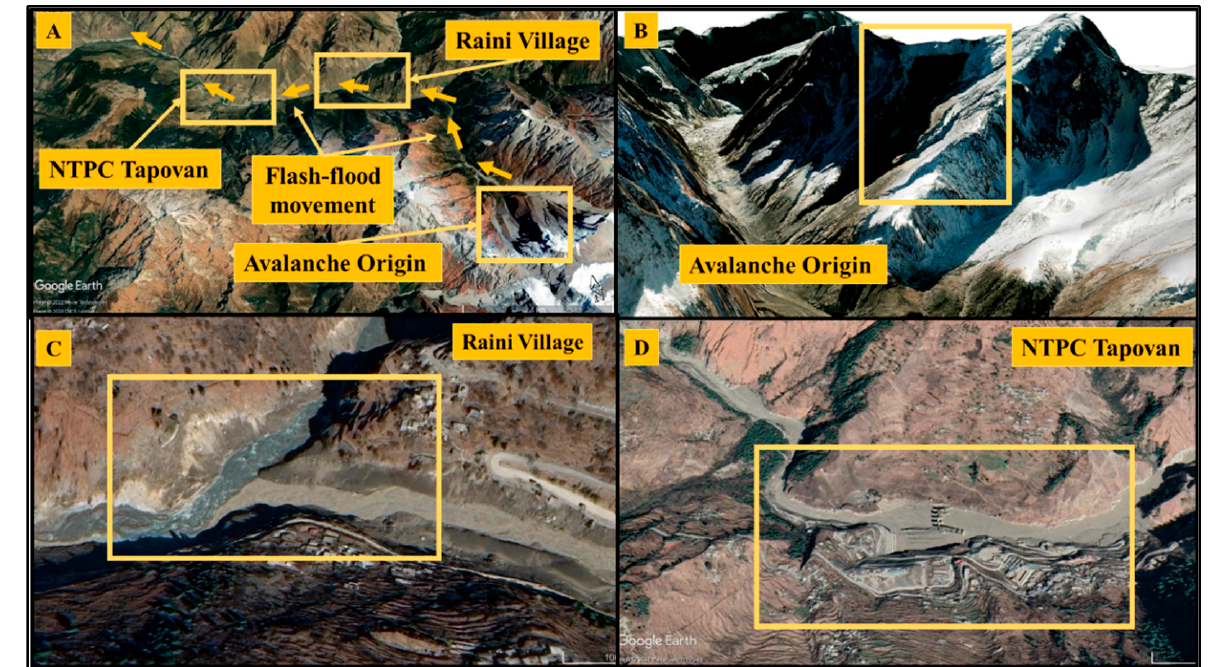
Figure 10. The Google Earth imagery shows, ( A ) An overall view of the incident, ( B ) The actual location of the avalanche near Ronti Glacier, ( C ) The confluence of Dhauliganga and Rishiganga, near Raini village, and ( D ) The inundated NTPC Tapovan sites.